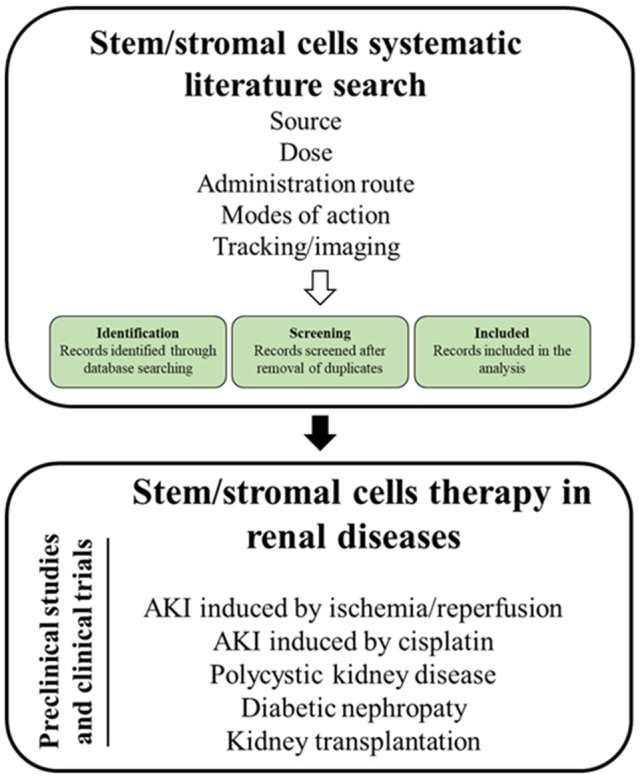
Graphical abstract.